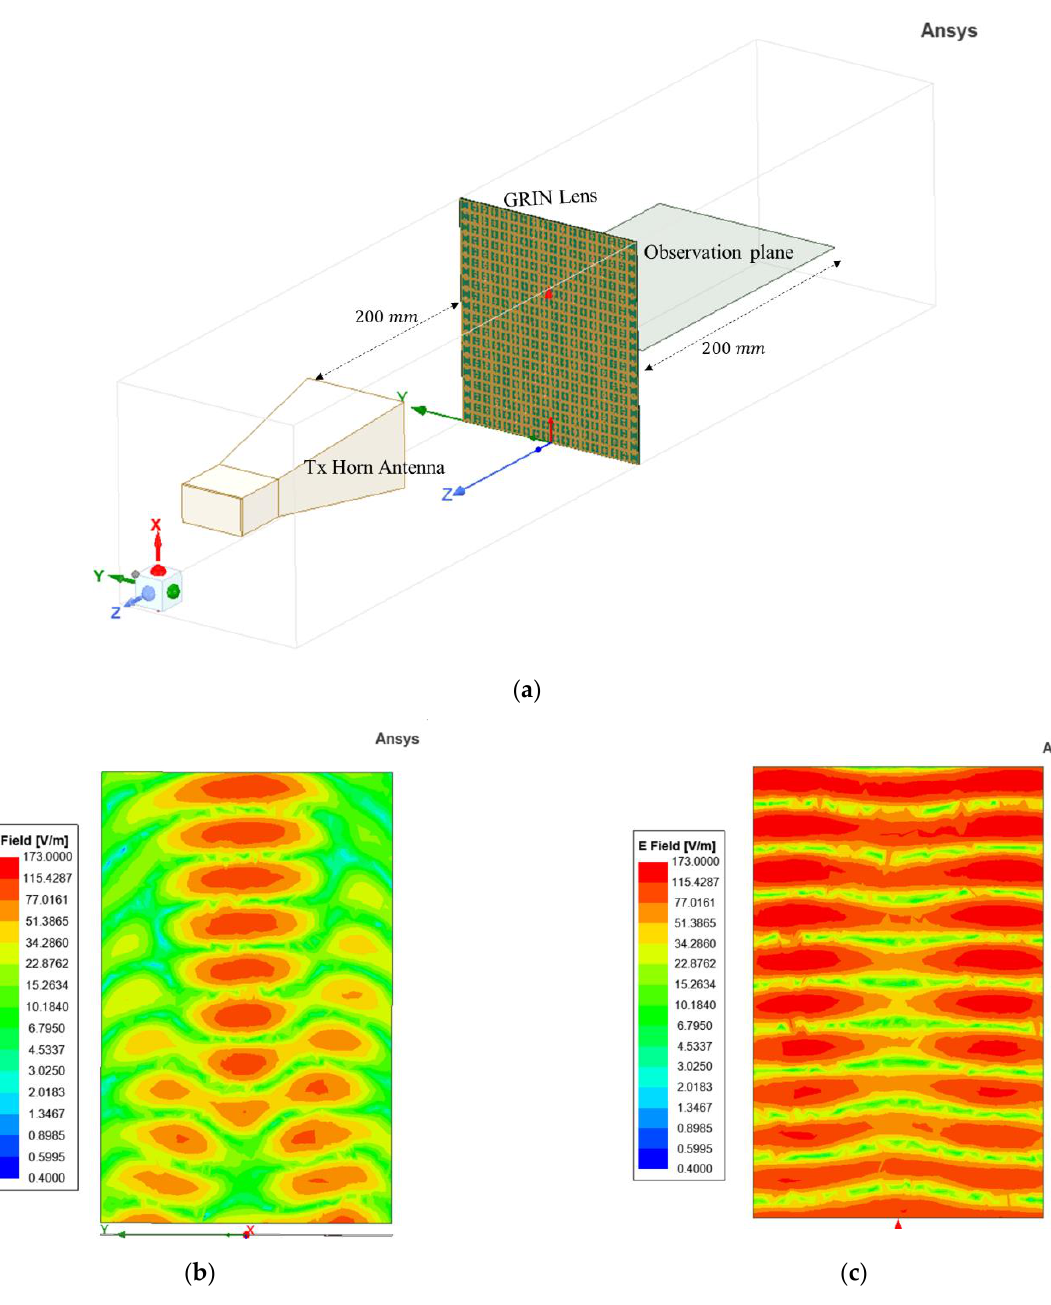
Figure 6. ( a ) HFSS setup for focusing simulation of 1D GRIN lens. ( b ) Simulated 𝐸 field distribution with lens. ( c ) Simulated 𝐸 field distribution without lens.